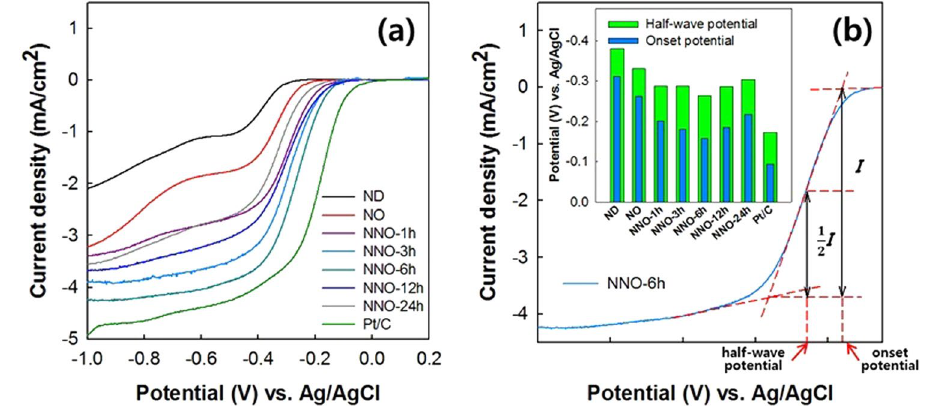
Figure 6. ( a ) LSV curves of the ND, NO, NNO-1h, NNO-3h, NNO-6h, NNO-12h, NNO-24h, and Pt/C samples and ( b ) their onset and half-wave